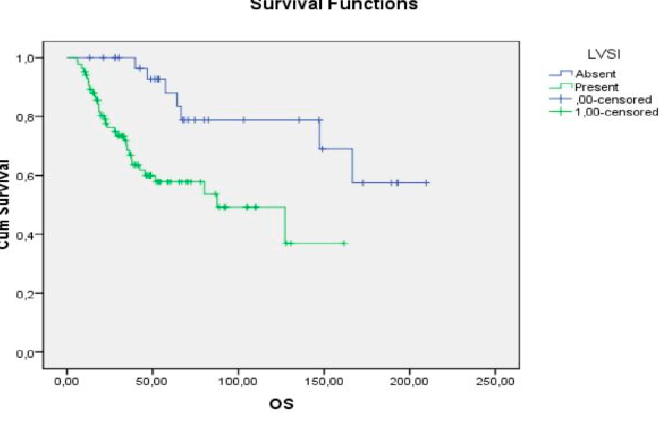
Figure 1. OS according to